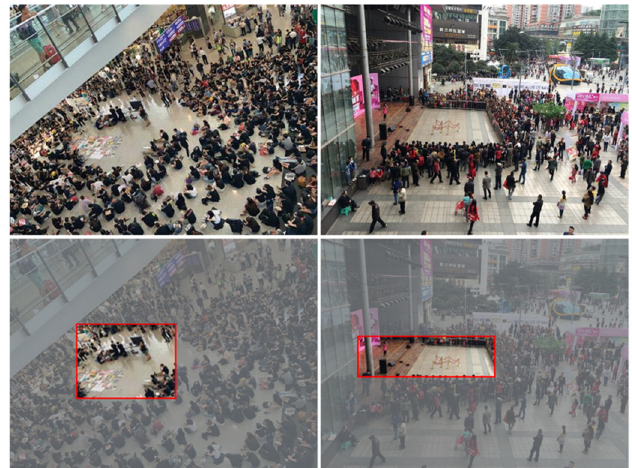
Figure 1. Examples of an important area in a gathering place. The first and second rows show the original images and important area with red rectangles, respectively.